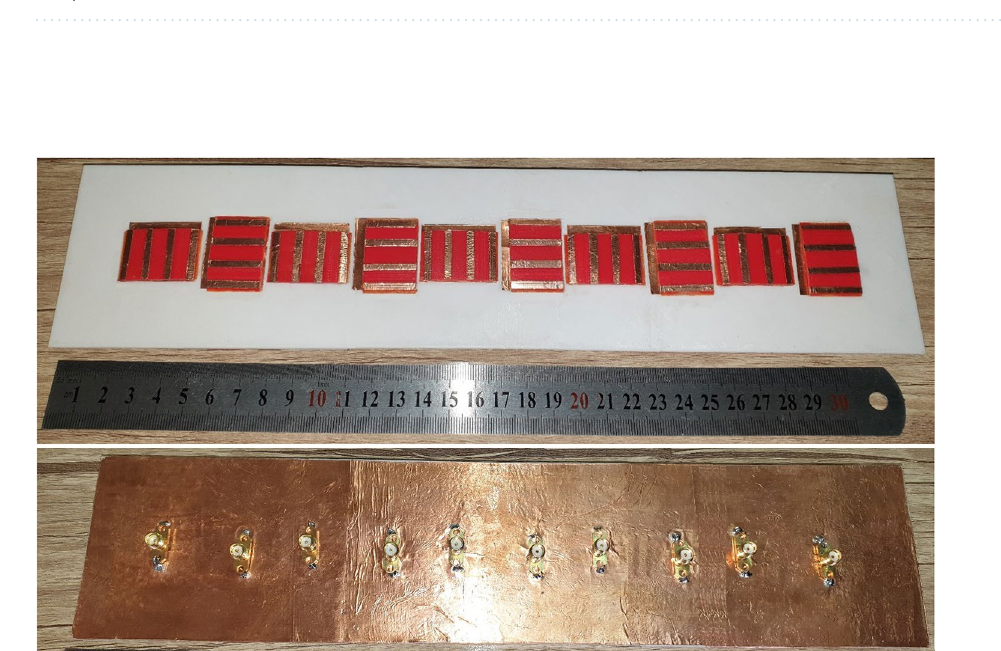
Figure 8. Simulated reflection coefficients of the interleaved elements of the ( a ) cloaked array I, and ( b ) cloaked array II.